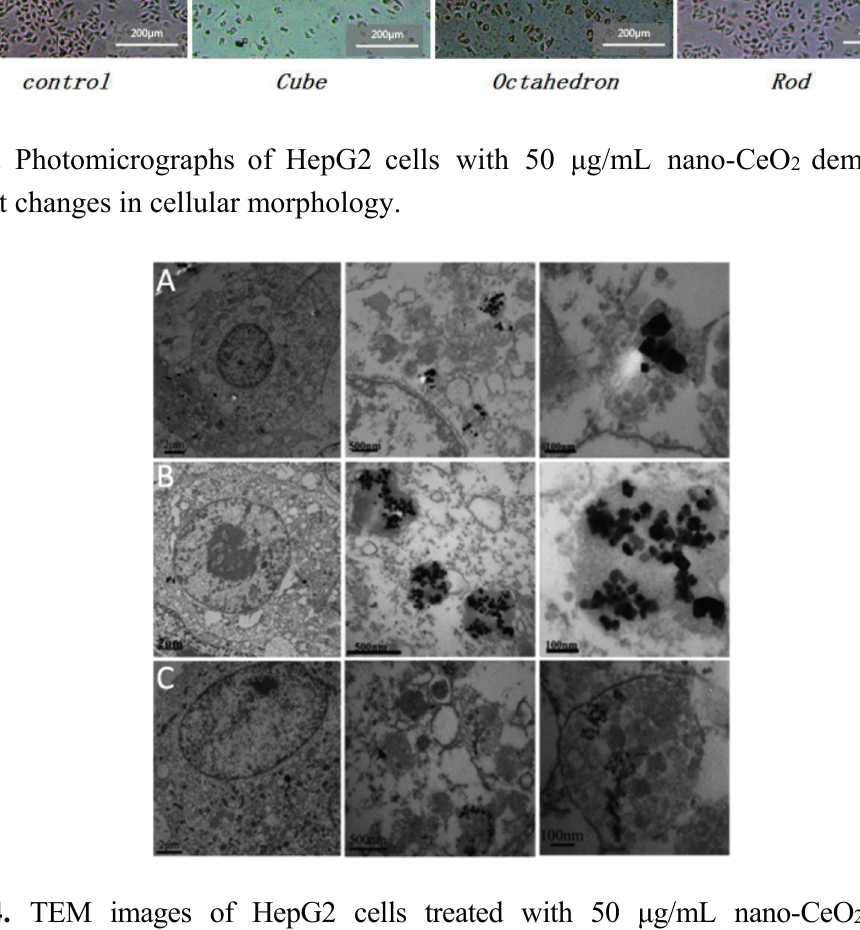
Figure 4. TEM images of HepG2 cells treated with 50 μ g/mL nano-CeO 2 for 24h. ( A ) Cubes; ( B ) octahedrons, ( C )